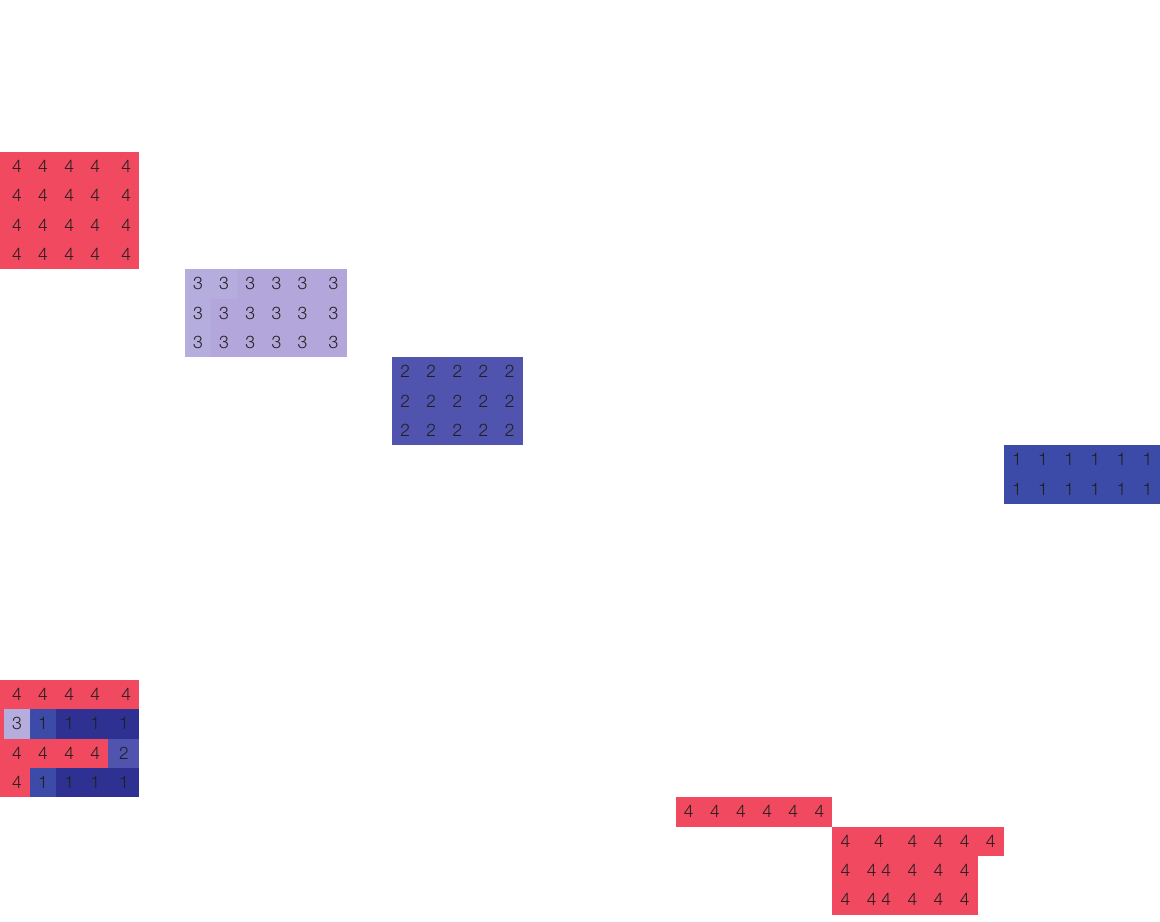
Numbers 1–4 and colors from blue to red represent the clustered data from days after onset. The numbers from 0 to 1,000 indicate the days after onset for each